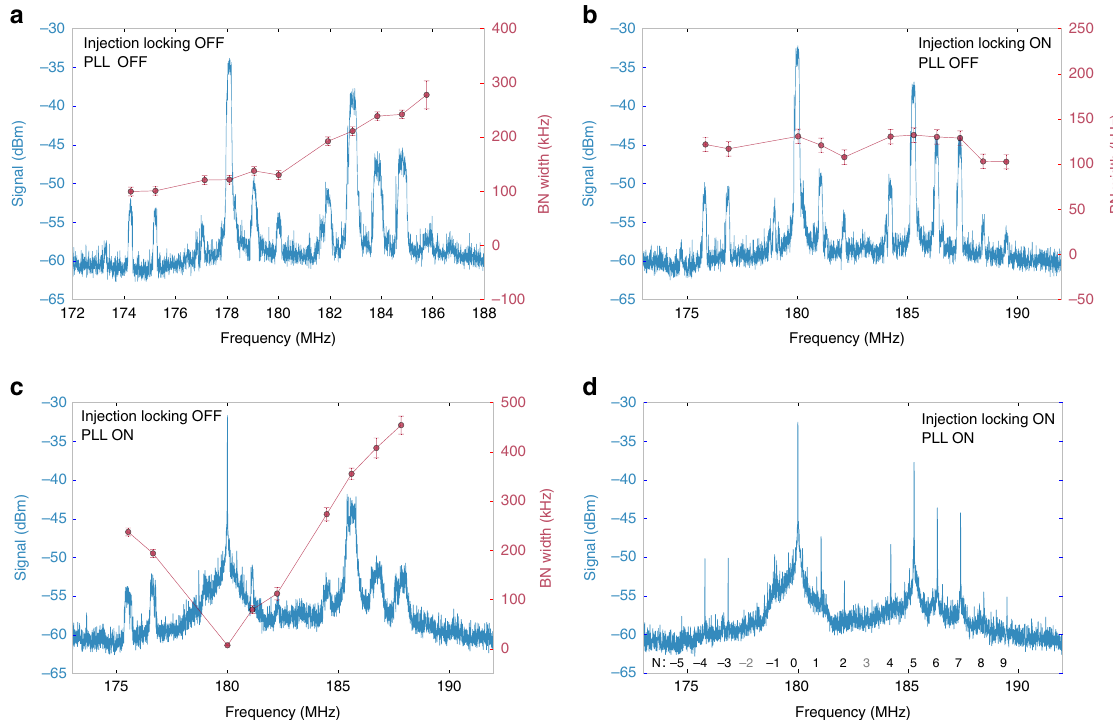
Fig. 2 Radio frequency (RF) spectra. RF-comb spectra (blue traces) and related width of each beat-note (red dots), the uncertainty bars have been calculated as standard deviation on a set of 20 acquisitions. In all the acquisitions the optically-recti fi ed THz frequency comb is fully stabilized, while the QCL-comb is: a free-running; b stabilized mode spacing and free-running offset frequency; c free-running spacing and stabilized offset; d fully stabilized. The order N of each comb mode is labeled in d , N = 0 indicating the mode used for offset frequency stabilization